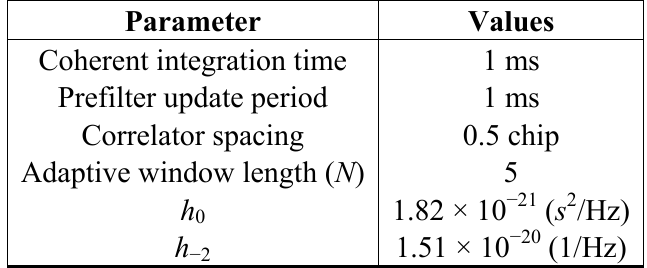
Table 2. Parameters defined in software-defined COMPASS